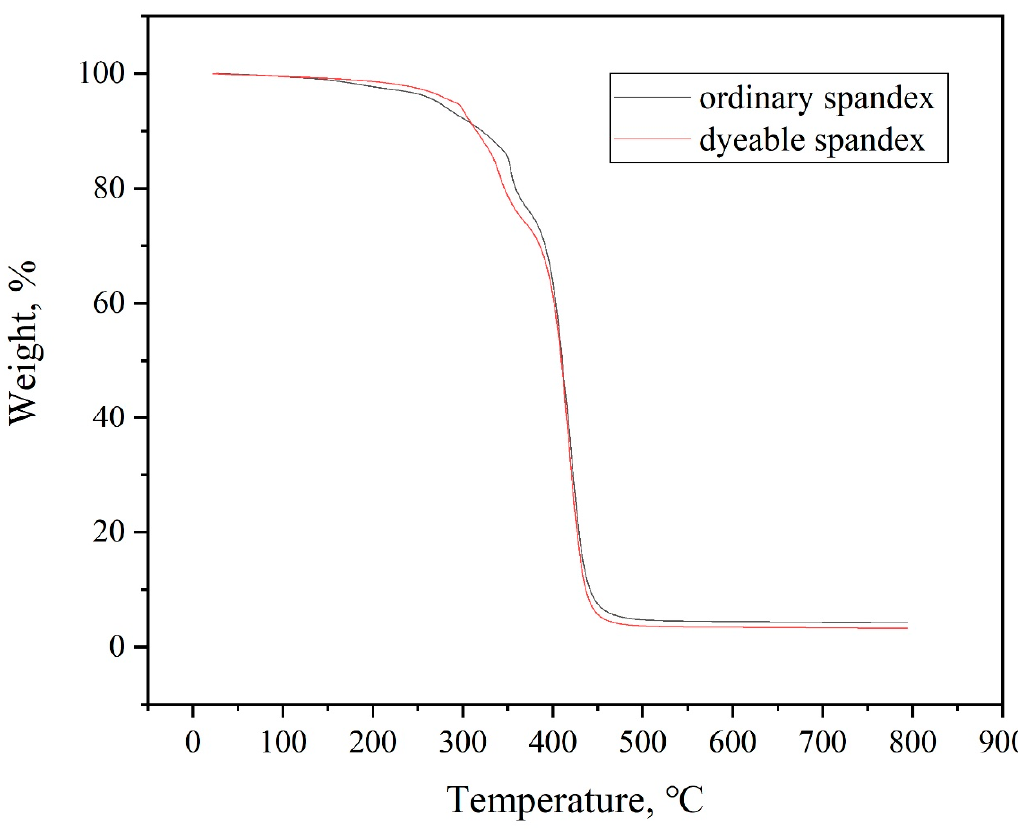
Figure 3. TG curves of dyeable spandex and ordinary spandex.